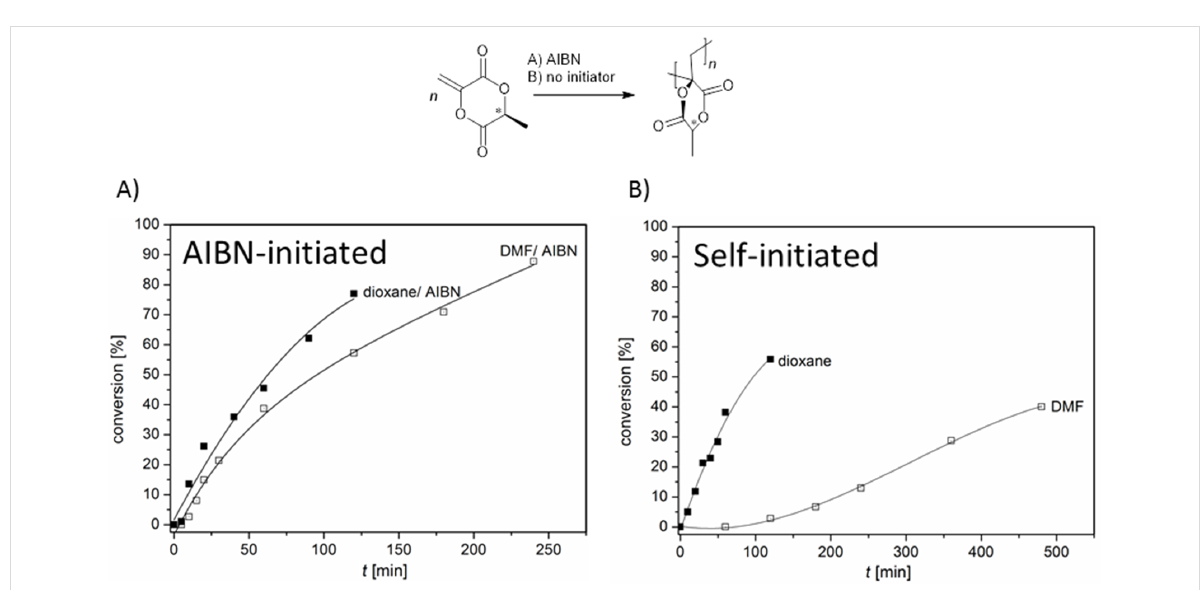
Figure 5: Conversion plot of the polymerization of MLA in 1,4-dioxane and DMF ( c MLA = 1.8 mol L − 1 , c AIBN = 1.8 × 10 − 2 mol L − 1 , 70 °C) with AIBN (A) and without initiator (B).